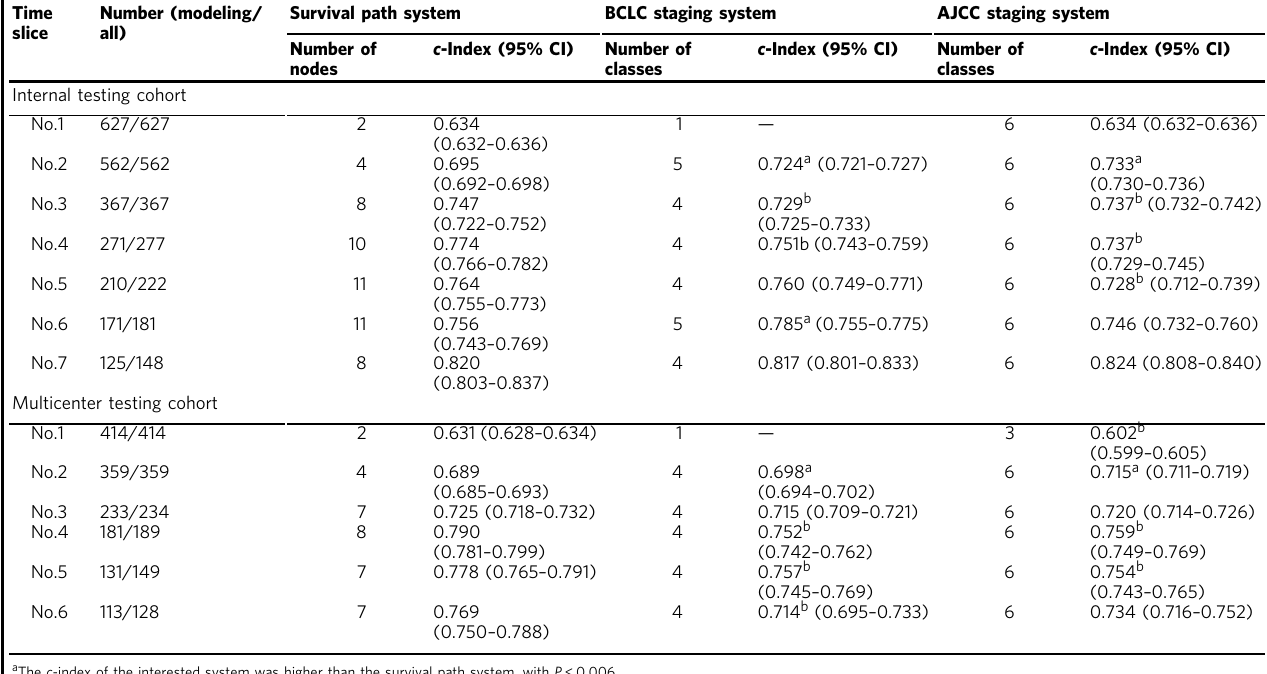
Table 3 Comparison of c -index between the survival path system, BCLC staging system, and AJCC staging system in the internal testing cohort and multicenter testing cohort